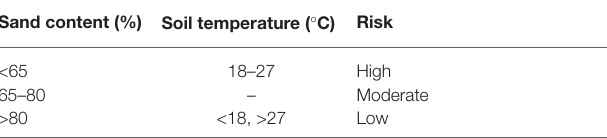
TABLE 1 | Phylloxera risk classes based on soil sand and temperature